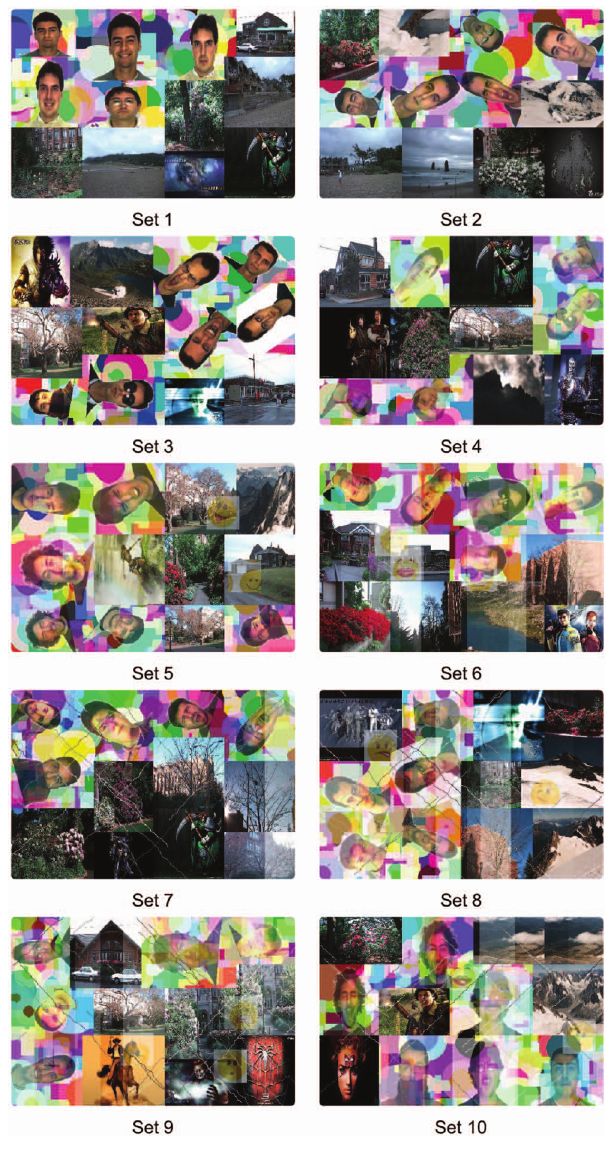
Figure 5. Examples of FR-CAPTCHA. The CAPTCHAs are numbered according to the set numbers assigned in Tables 1 and